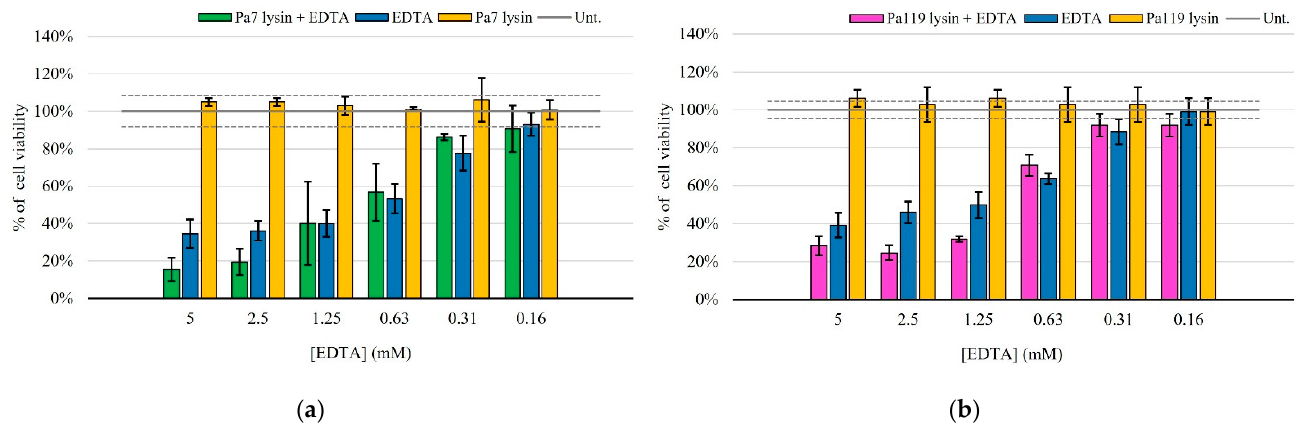
Figure 4. Antibacterial activity of lysins Pa7 ( a ) and Pa119 ( b ) in combination with the outer mem- brane permeabilizer EDTA in P. aeruginosa ATCC 27853. Results are shown as % of cell viability upon treatment and are based on three independent assays. Green—Pa7 lysin in combination with EDTA; pink—Pa119 lysin in combination with EDTA; blue—EDTA only; yellow—each lysin (Pa7 ( a ) or Pa119 ( b )) applied solely. Untreated control is represented as a solid gray line, with the respective 95% confidence interval represented as dashed gray lines.